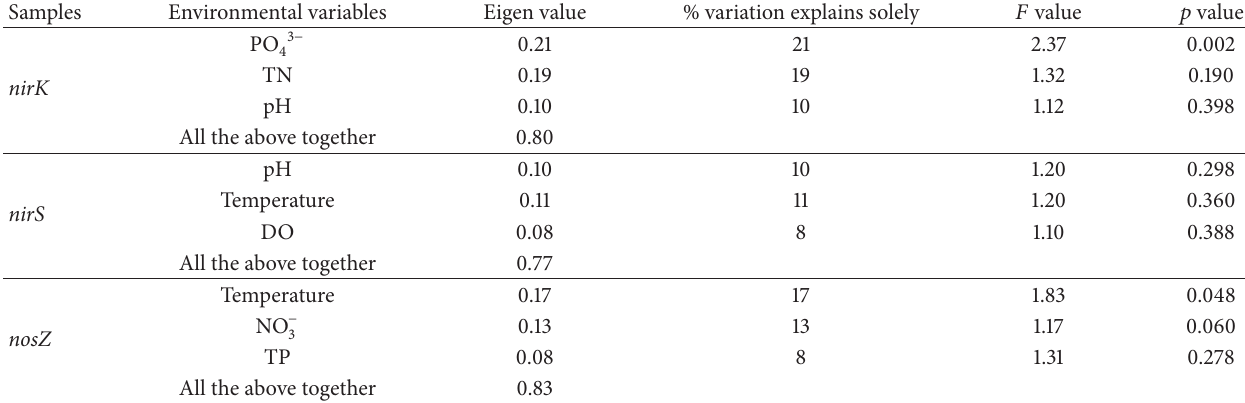
Table 4: Eigen values, 𝐹 values, and 𝑝 values obtained from the partial RDAs testing the influence of the significant parameters on the denitrifying bacterial community composition ∗